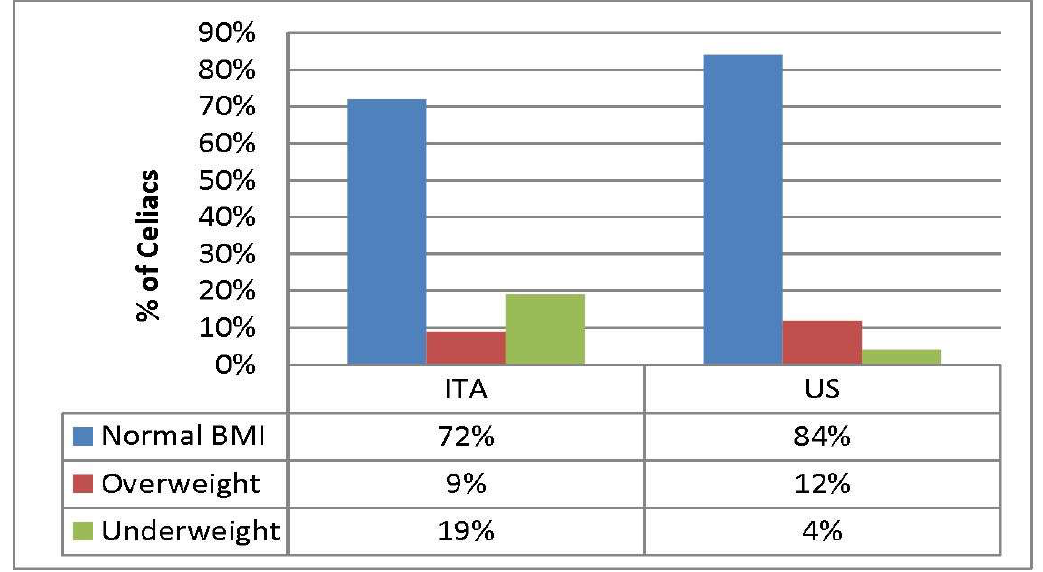
Figure 3. BMI at follow up in celiac groups.